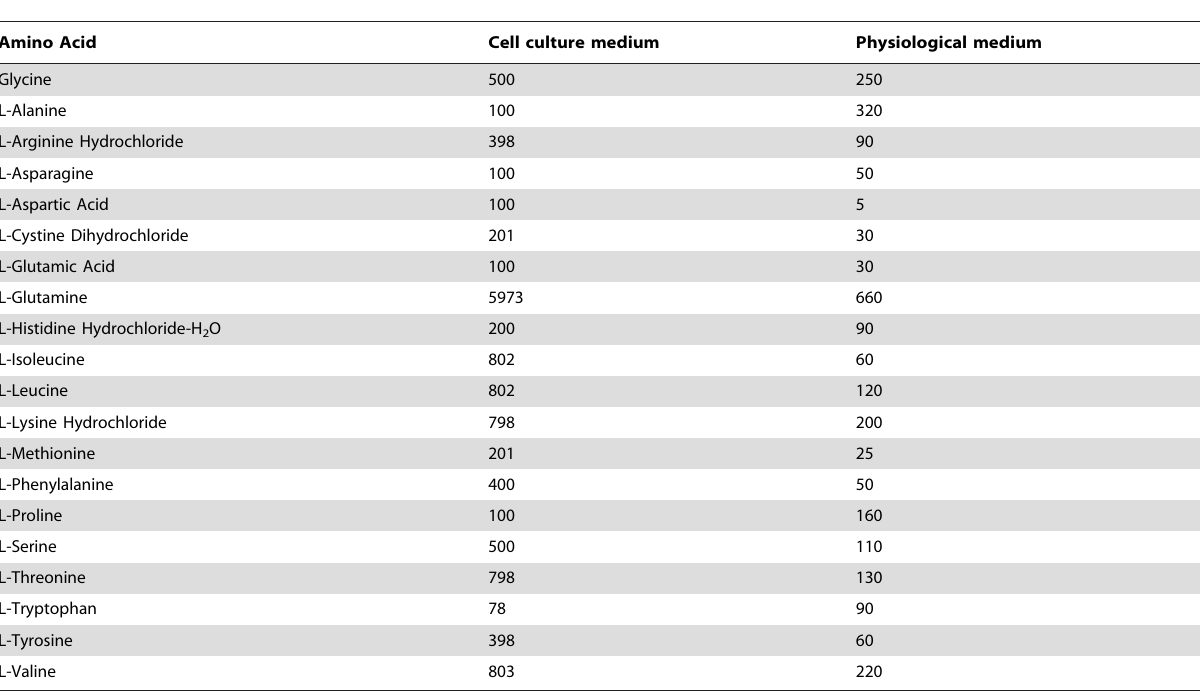
Table 1. Amino acid concentrations ( m M) in cell culture and physiological media.